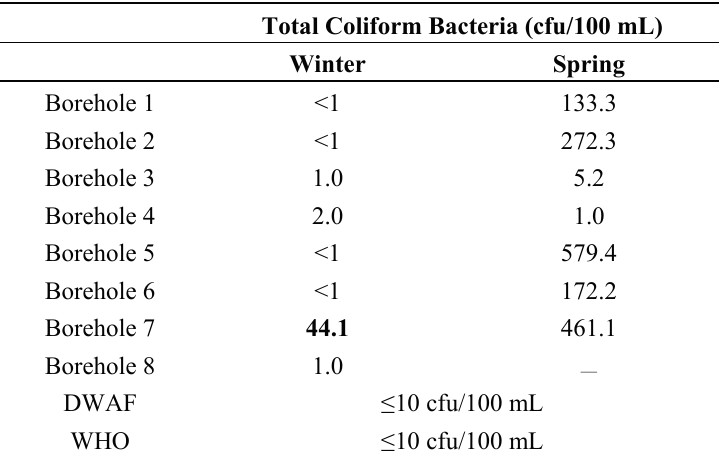
Table 2. Results of the bacteriological